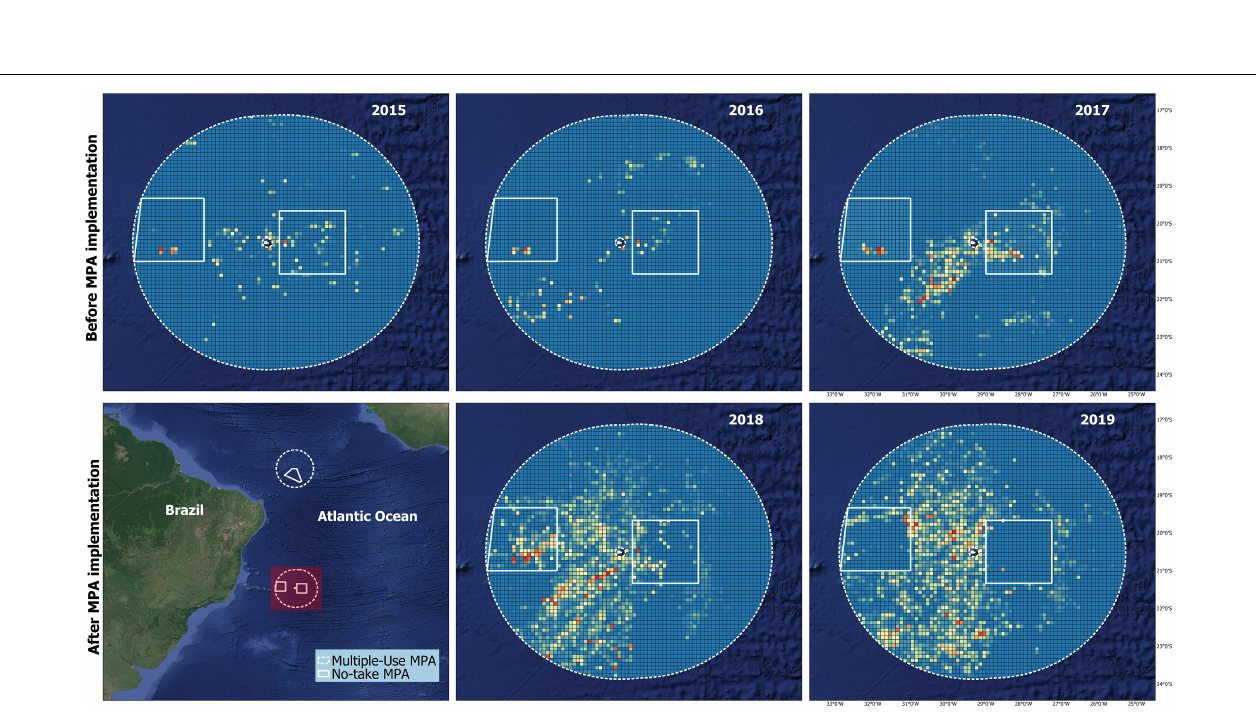
FIGURE 1 | Occurrence of fishing activity (“likely fishing days”) within the no-take and multiple-use large-scale marine protected areas (MPAs) surrounding the São Pedro and São Paulo Archipelago (SPSP) over 5 years: 2015–2017 ( top row ), when the MPAs had not been declared; and 2018–2019 ( bottom row ), when the MPAs have been established.